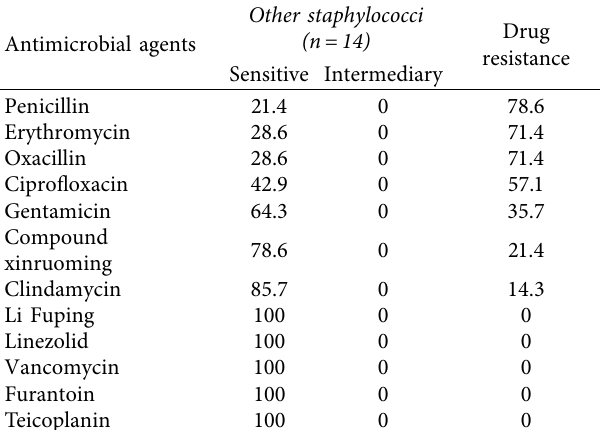
Figure 1: Distribution of pathogenic bacteria detected in blood culture of 387 adult sepsis patients. Table 5: Resistance rate of Gram-positive Staphylococcus aureus (%).